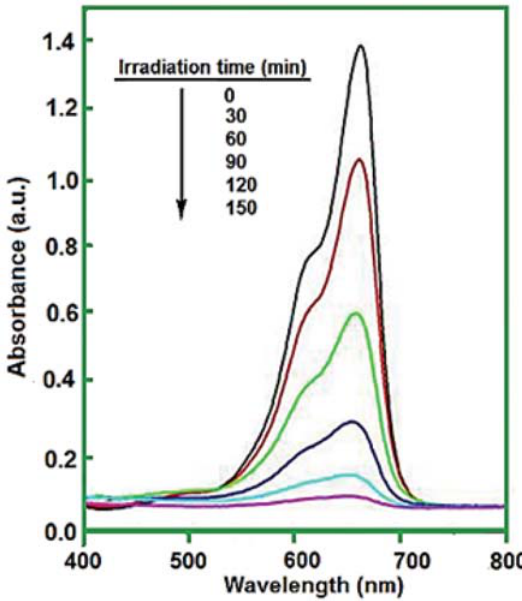
Figure 10. Evolution of UV-vis absorption spectrum of methylene blue (MB) under irradiation at different times using Co particles in the presence of H